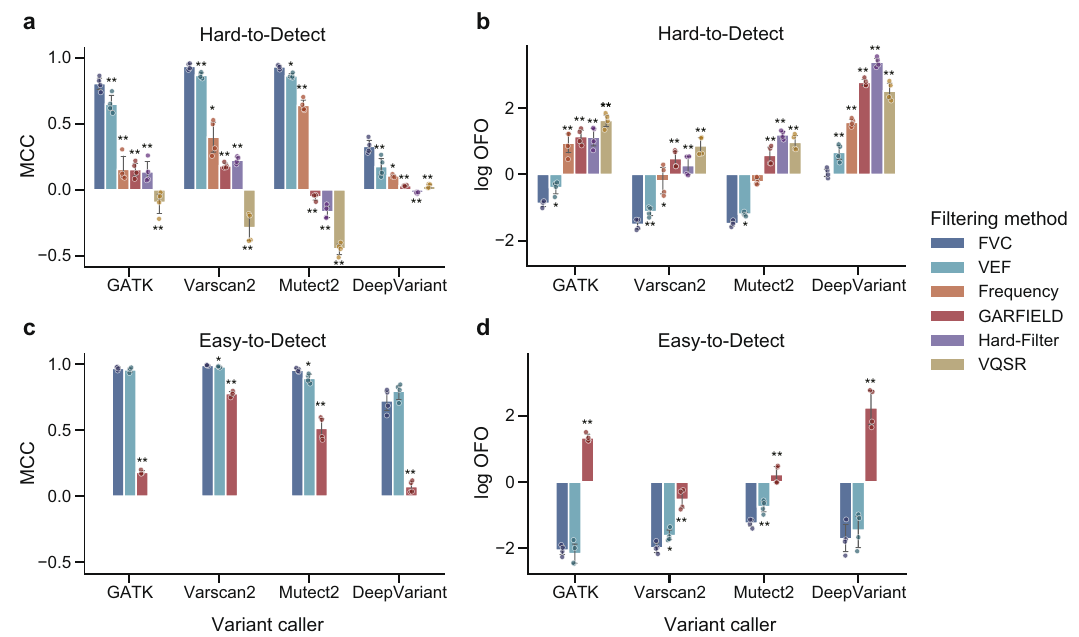
Fig. 4 The performance of different fi ltering methods when applied to hard-to-detect or easy-to-detect variants. The easy-to-detect and hard-to-detect variant calls used as testing data are derived from the whole-genome sequencing datasets (HG001, HG003, HG004, and HG006) at 30× coverage and identi fi ed by GATK, Varscan2, Mutect2, and DeepVariant, separately. The easy-to-detect variants are de fi ned as the variants that are consistently and correctly classi fi ed by all the unsupervised fi ltering methods (Frequency, Hard-Filter, and VQSR). The other variants are de fi ned as hard-to-detect variants. The performance of the fi ltering methods is assessed on the a hard-to-detect variants using MCC; b hard-to-detect variants using OFO; c easy-to-detect variants using MCC (Frequency, Hard-Filter, and VQSR consistently scored MCC = 1); and d easy-to-detect variants using OFO (Frequency, Hard-Filter, and VQSR consistently scored logOFO = − ∞ ). The circle indicates the metric score achieved by the fi ltering method when applied to each speci fi ed testing data. The error bar indicates the 95% con fi dence intervals ( n = 4 biologically independent samples). Asterisk denotes the signi fi cance of the comparison using a one-sided paired T-test (* p < 0.05, ** p < 0.001), where the null hypothesis is that the FVC performs no better than the compared